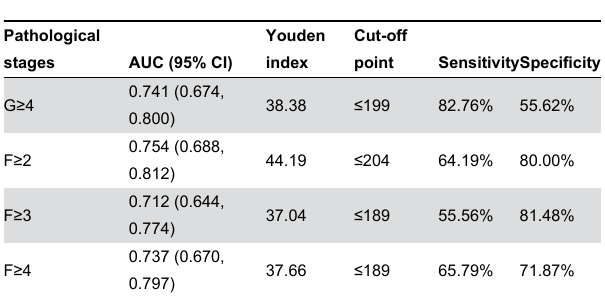
Table 4. CP values distinguish different stages of inflammation and fibrosis as measured by AUC (N=109).